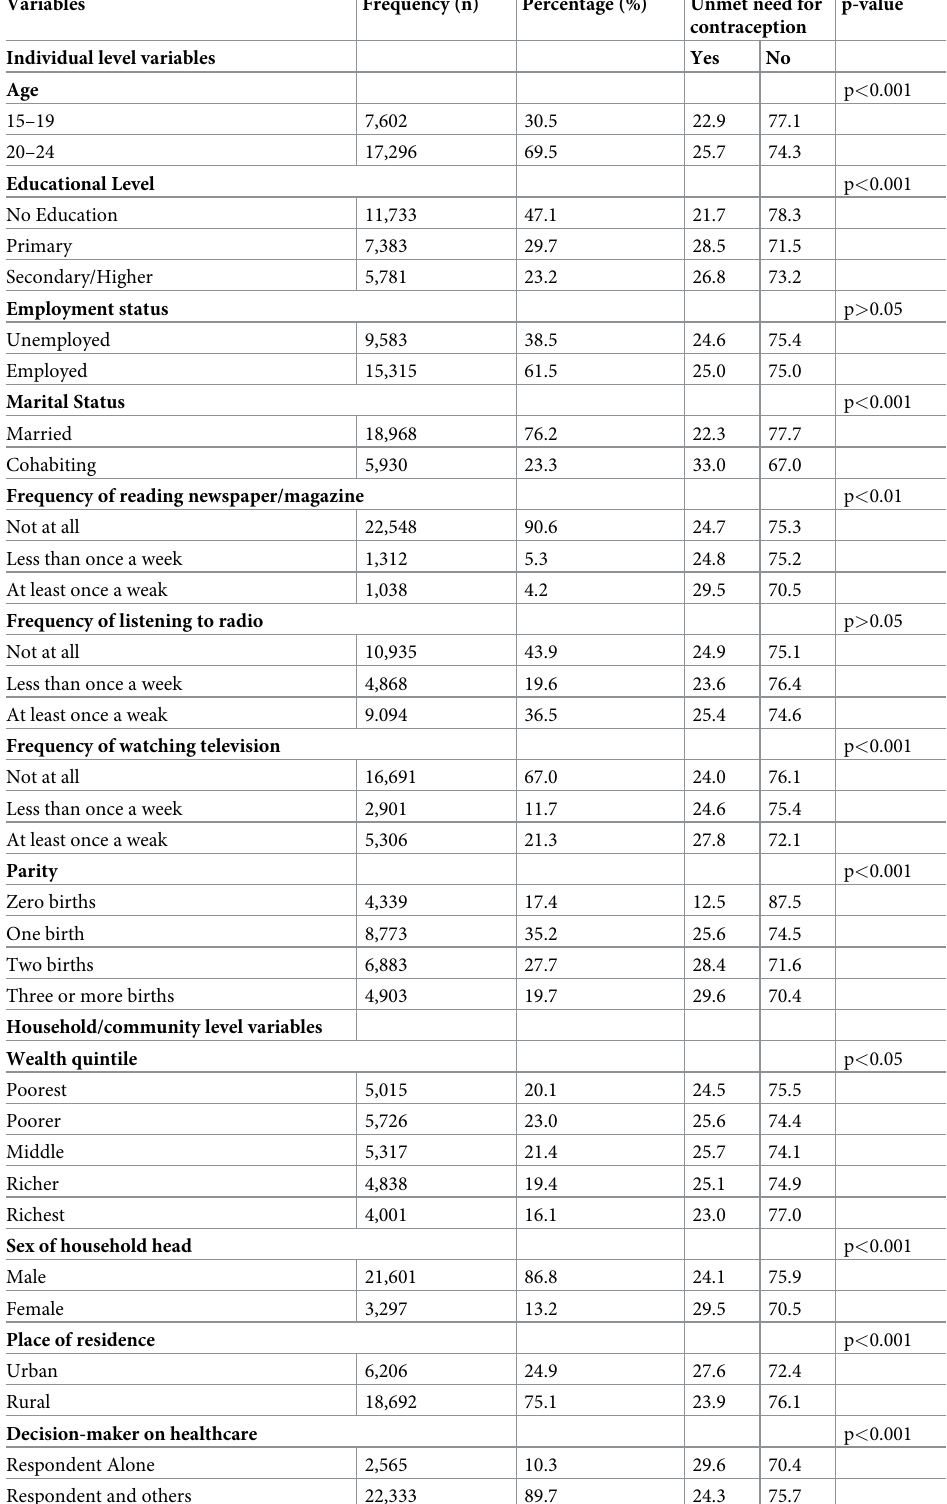
Table 2. Distribution of unmet need for contraception among adolescent girls and young women by the explana- tory variables